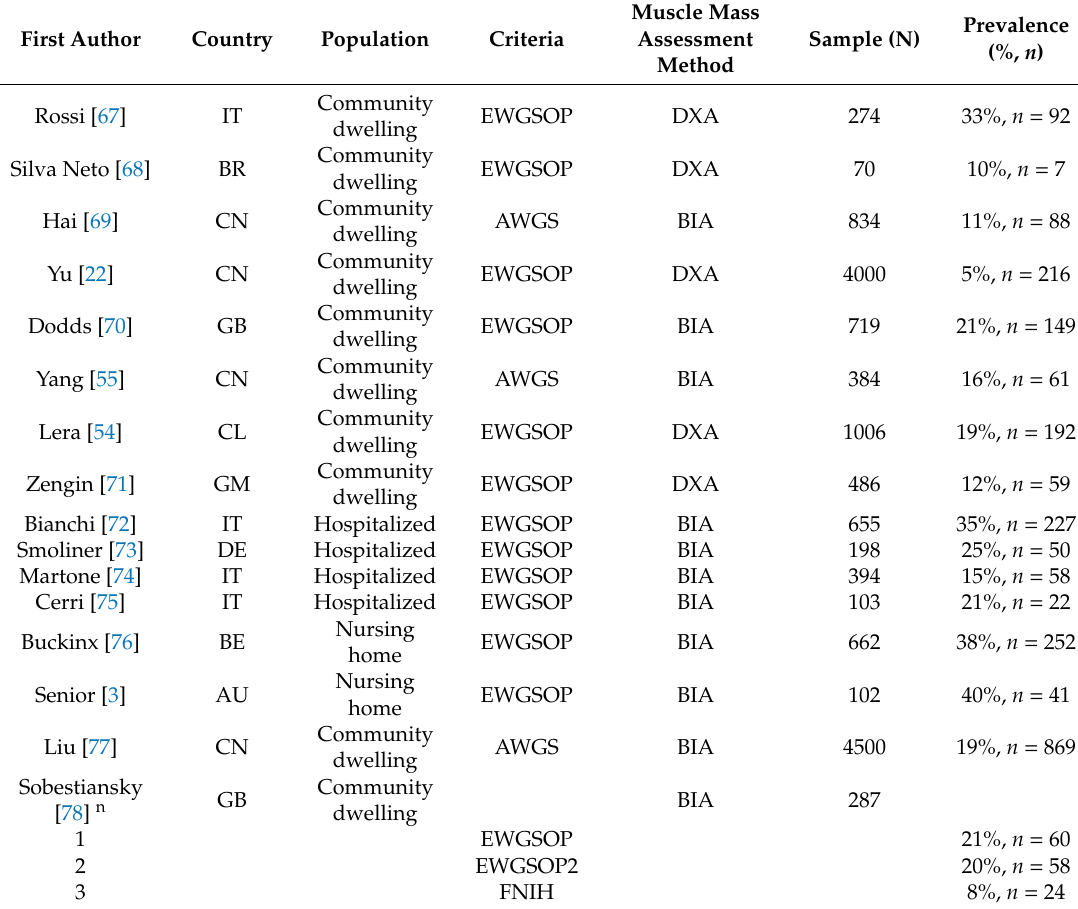
Table 1. Di ff erences in the prevalence of sarcopenia according to the assessment method used and the population